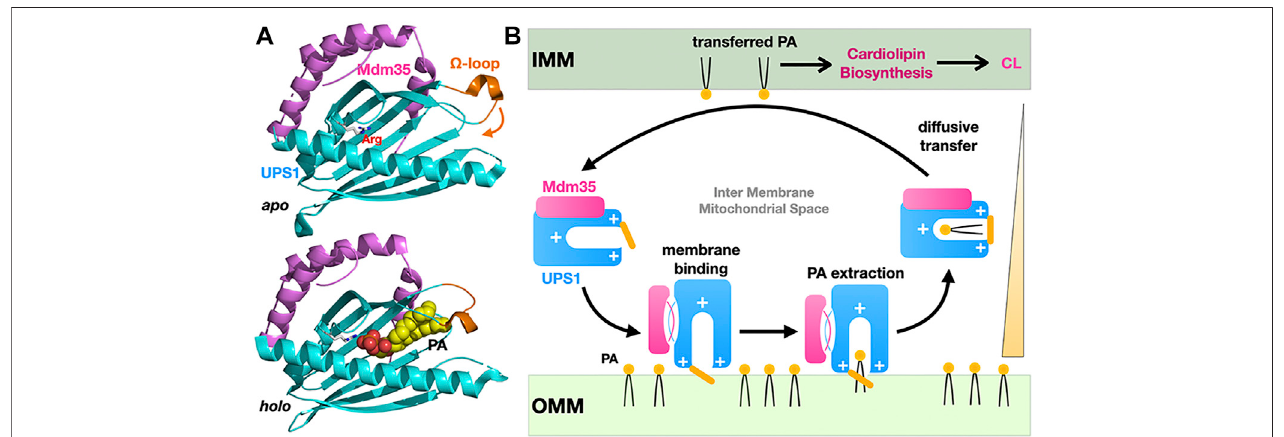
FIGURE 5 | Diffusive transfer of phosphatidic acid between mitochondrial membranes by the soluble LTP Ups1/Mdm35. (A) Structures of the apo and PA-bound Ups1/Mdm35solubleLTPcomplexesemphasizingthepolararginineclasp(sphere)atthebottomofthePA-bindingpocket,the Ω -loop(orange)sealingthehydrophobic cavity entrance and involved in membrane attachment and PA extraction. The apo and holo structures are shown in the same orientation. (B) Simpli fi ed cycle for the diffusive LTP-assisted transfer ofPA between mitochondrialmembranes. Mdm35 reversible dissociation from Ups1 enhances its membrane association. Diffusive transfer is driven by the PA concentration gradient as transferred PA fuels CL biosynthesis (PDB